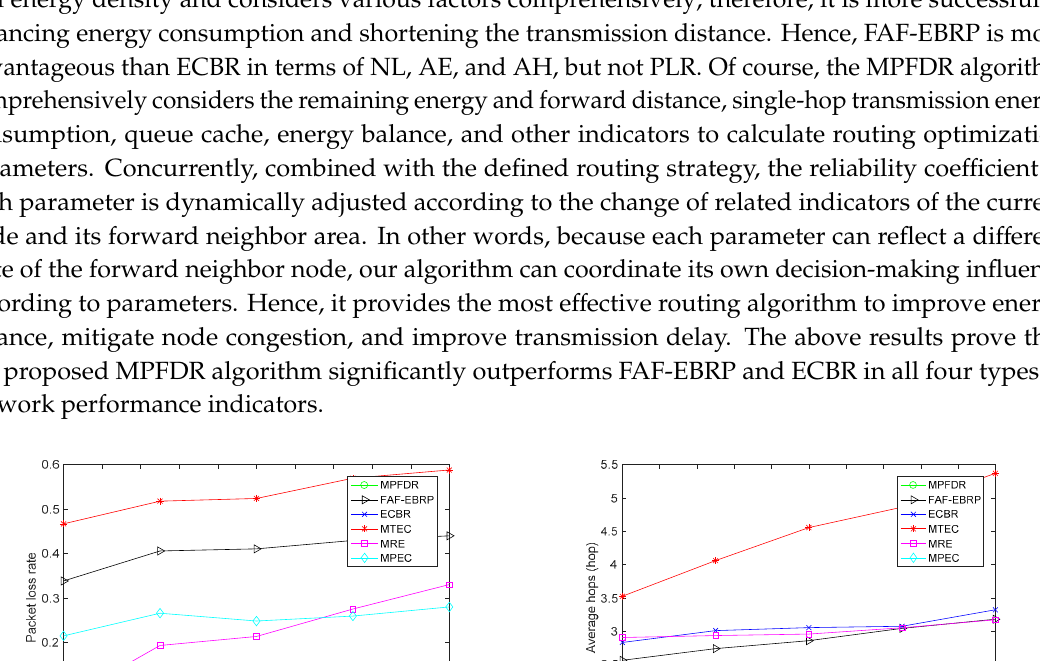
Figure 4. ( a ) NL versus different number of nodes; ( b ) AE versus different number of nodes.